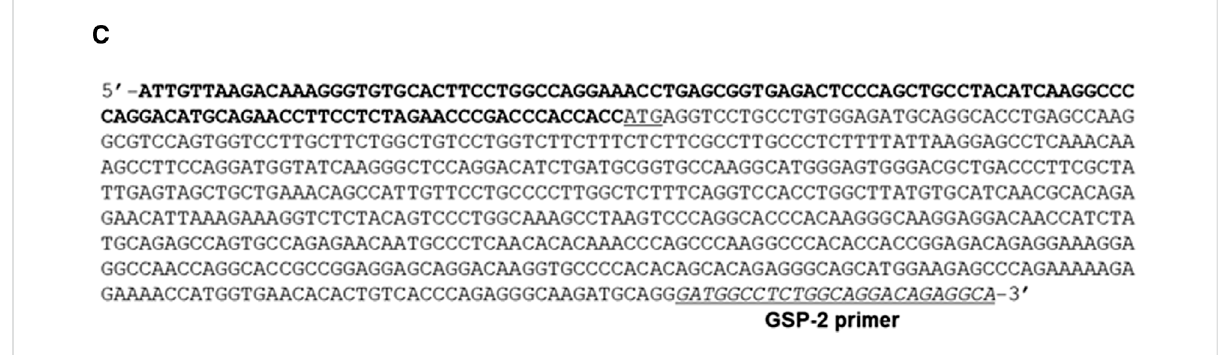
FIGURE 3 Identi fi cation of the transcription start site in the 5 ′ - fl anking region of hST6GalNAc I gene by 5 ′ RACE-PCR in curcumin-induced HCT116 cells. Total RNA from HCT116 cells was prepared after 50 µM curcumin treatment for 24 h (A) RT reaction was performed using GSP RT primer and PCR was performed with Gene RACE primer and Gene speci fi c primers with 5 ′ -RACE strategy. (B) Agarose gel (1%) analysis of the 5 ′ -RACE PCR product. Lane1;GeneRacer 5 ′ primerandGSP1primer,Lane2;GeneRacer 5 ′ Nestedprimer andGSP2primer. (C) Nucleotide sequencesofthe5 ′ -RACE PCR product (715 bp) ampli fi ed with GeneRacer 5 ′ Nested primer and GSP2 primer. 5 ′ -UTR sequences are shown in bold letter and the initiation codon (ATG) is